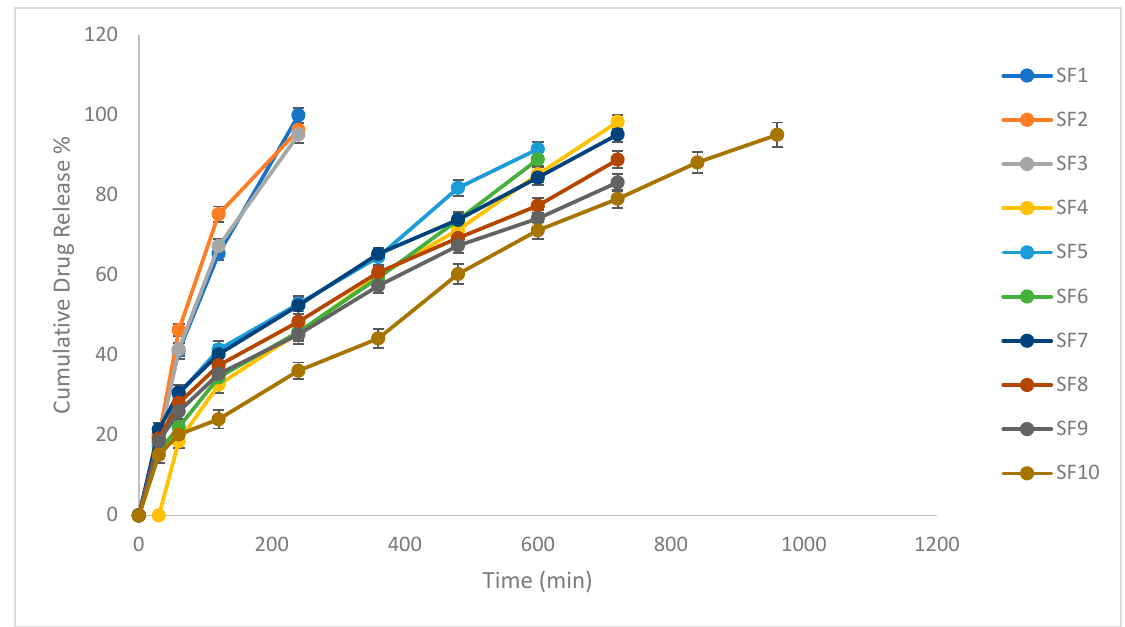
Figure 6. In vitro drug release.